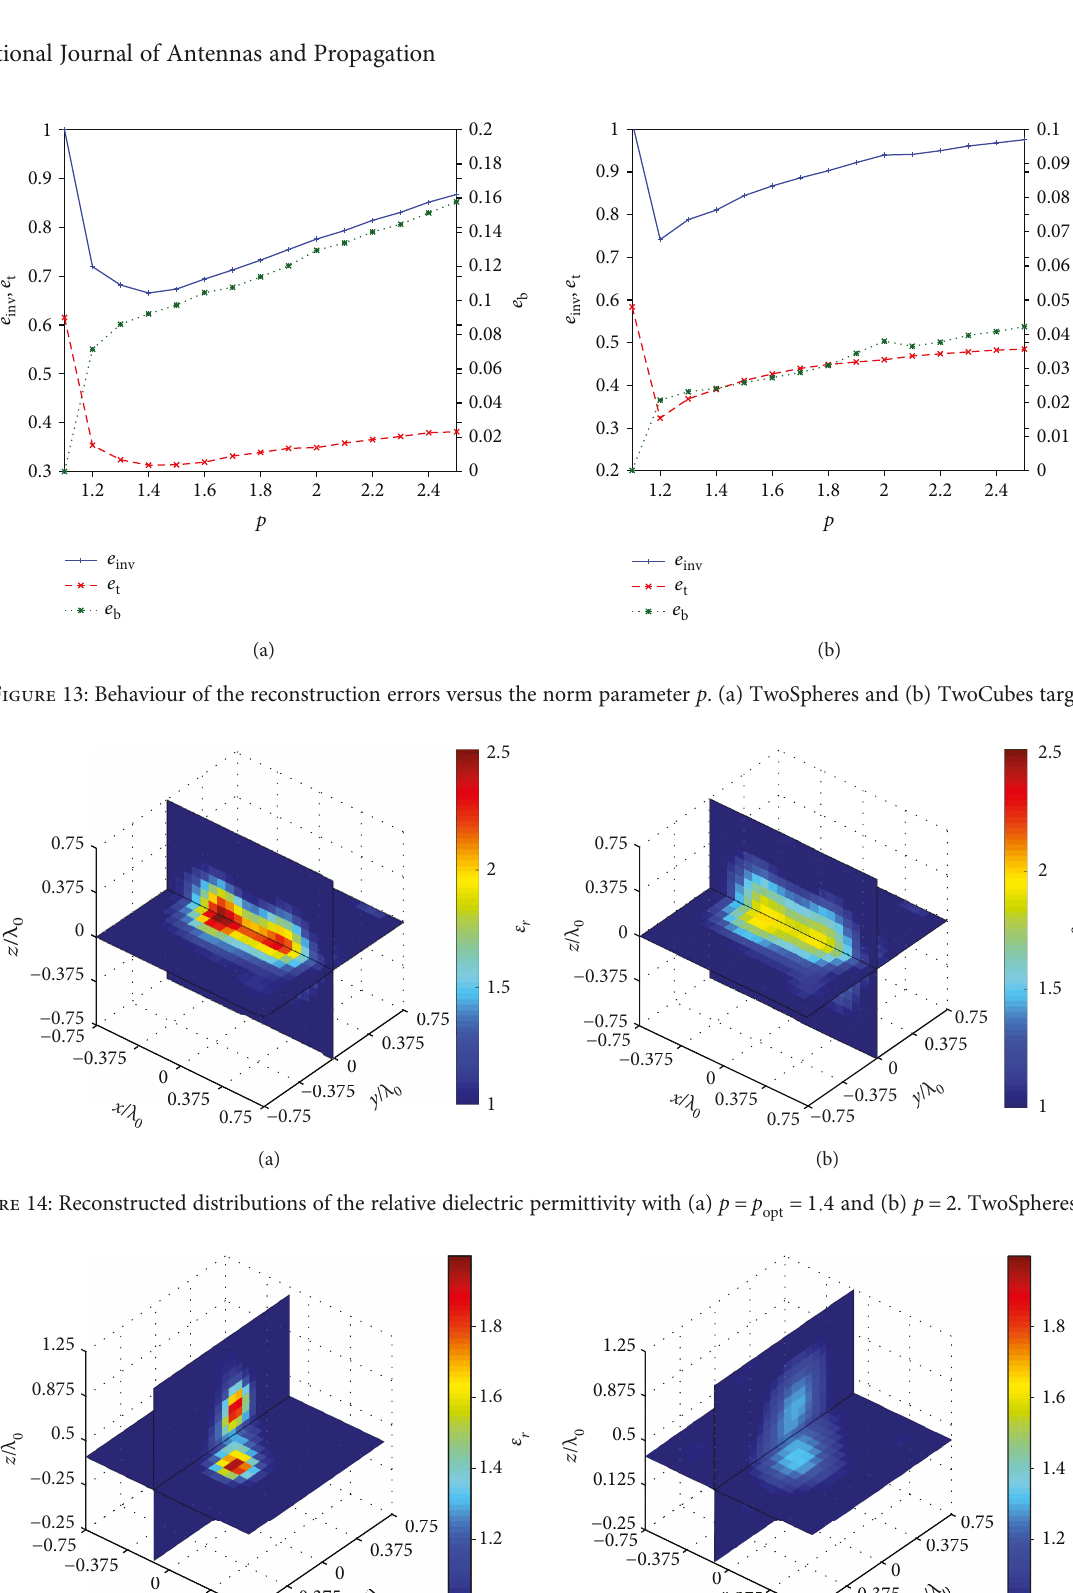
= 1 2 and (b) p = 2 . TwoCubes opt